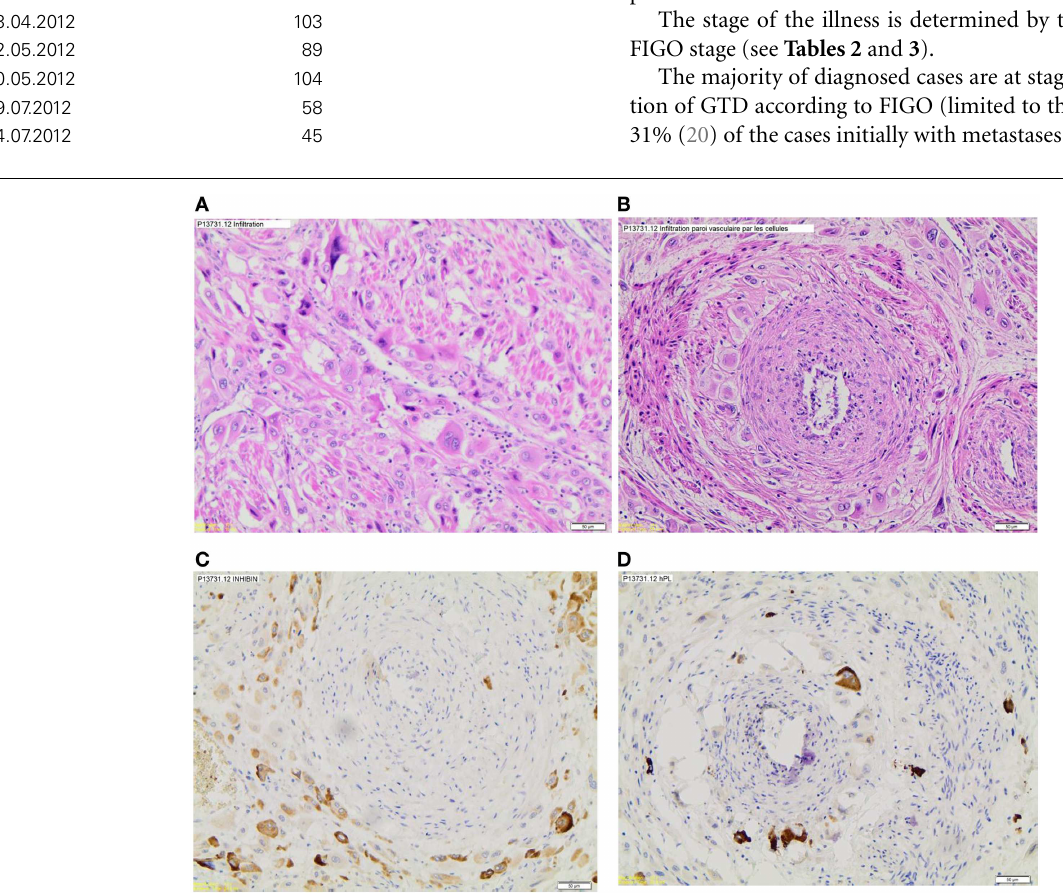
Frontiers in Surgery | Gynecology and